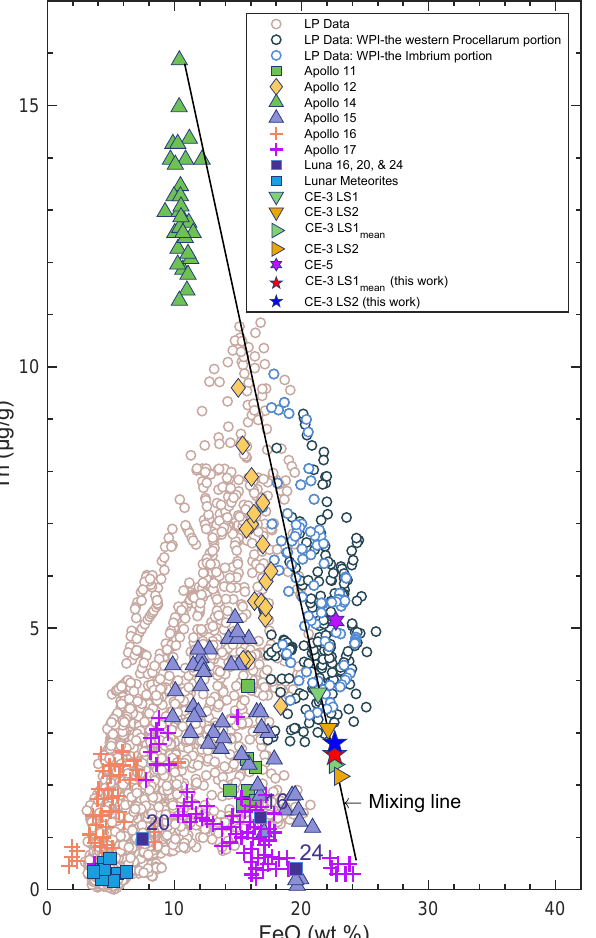
Figure 15. Scatter plot (Th versus FeO). In addition to similar indications to Figure 12, within the western Procellarum and Imbrium (WPI, cf. Prettyman et al., 2006 [10]), the portion of Imbrium and the portion of western Procellarum denote as blue and black dots, respectively